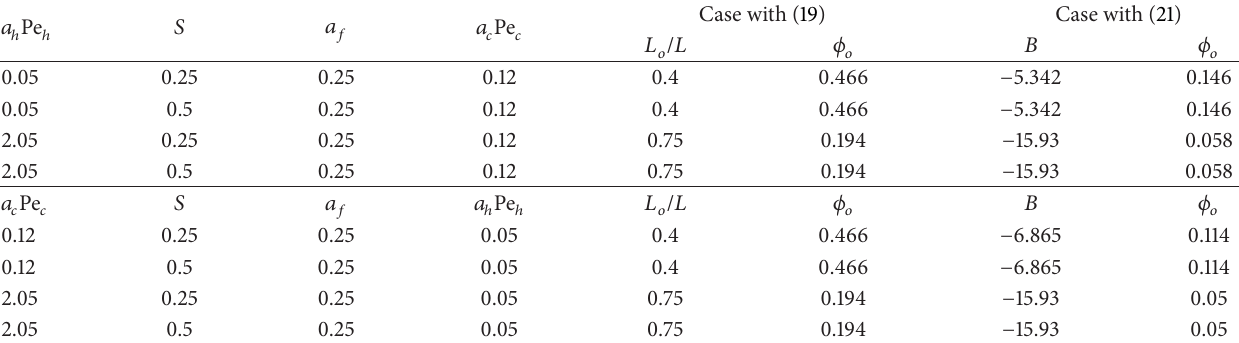
Table 3: Critical parameters for 𝜆 ℎ, max ( ∗ ) and 𝜆 𝑐, max ( ∗∗ ) as functions of 𝑎 ℎ Pe ℎ and 𝑎 𝑐 Pe 𝑐 , respectively ( 0.01 ≤ 𝑎 𝑓 ≤ 0.25, 0.12 ≤ 𝑎 𝑐 Pe 𝑐 ≤ 0.6, ≤ 2.14, 0.05 ≤ 𝜙 ≤ 0.5) 0.5 ≤ 𝑎 ℎ Pe ℎ 𝑜